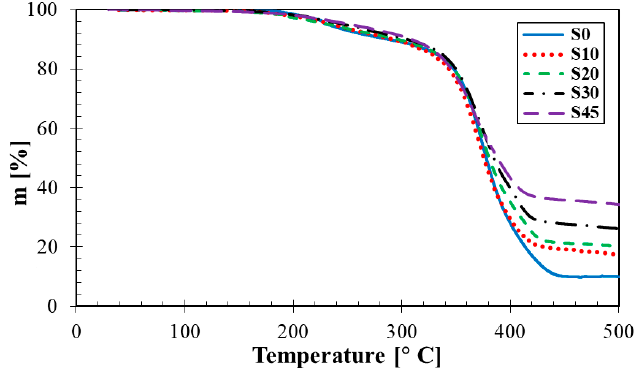
Figure 11. Thermogravimetric analysis results of the studied silica/rubber composites.